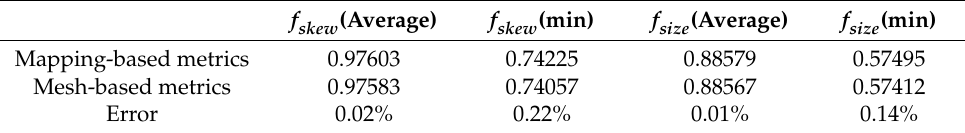
Figure 6. Mesh-based metrics of test case 1. Table 4. Comparison between the mapping-based metric and mesh-based metrics.